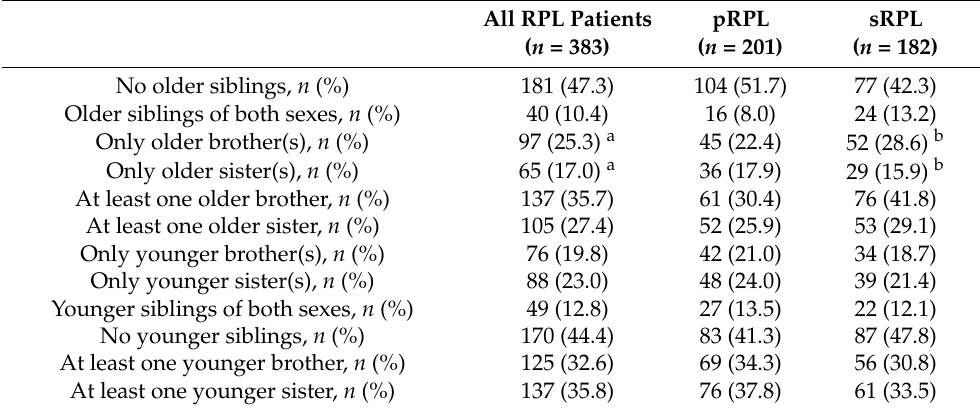
Table 1. Frequency of older siblings stratified according to sex in all RPL patients and in primary RPL (pRPL) and secondary RPL (sRPL) patients.